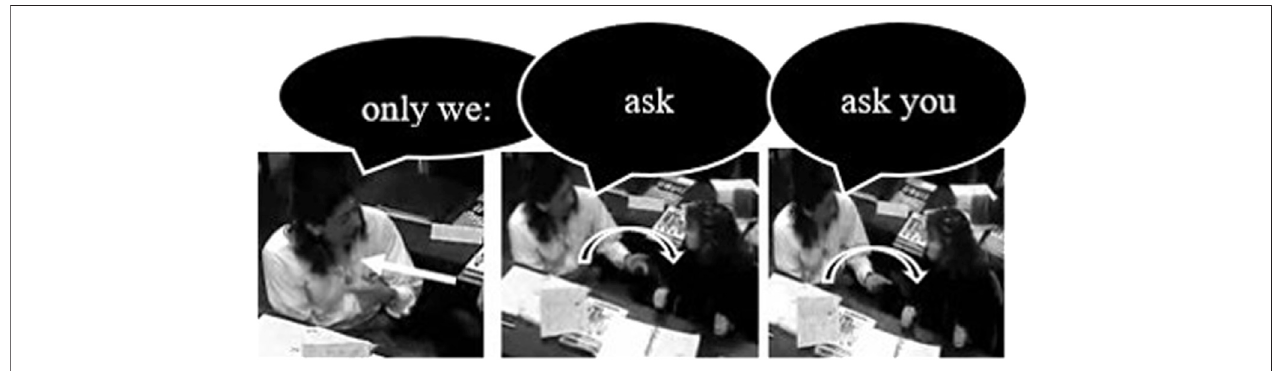
FIGURE 8 | Extract 4. line